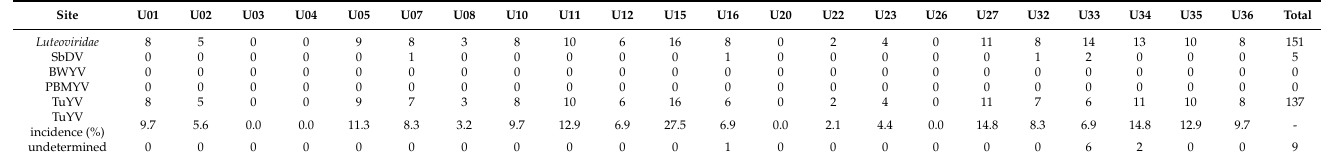
Table 4. Prevalence of virus infections ( Luteoviridae universal primers and species-specific primers) in Tasmanian pea crops and TuYV incidence calculated using the Gibbs and Gower method